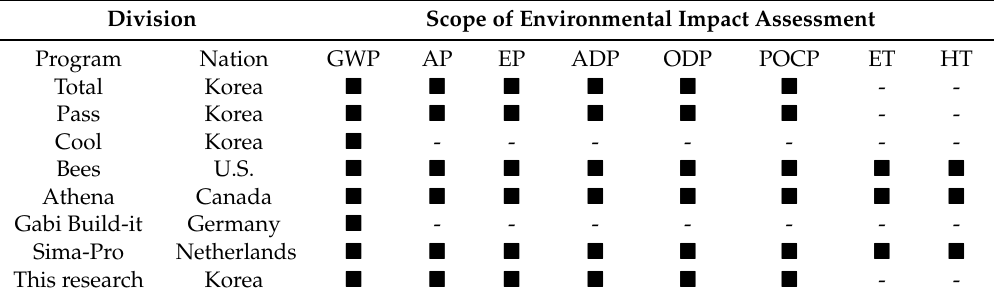
Table 1. Survey of Life Cycle Assessment (LCA) program.